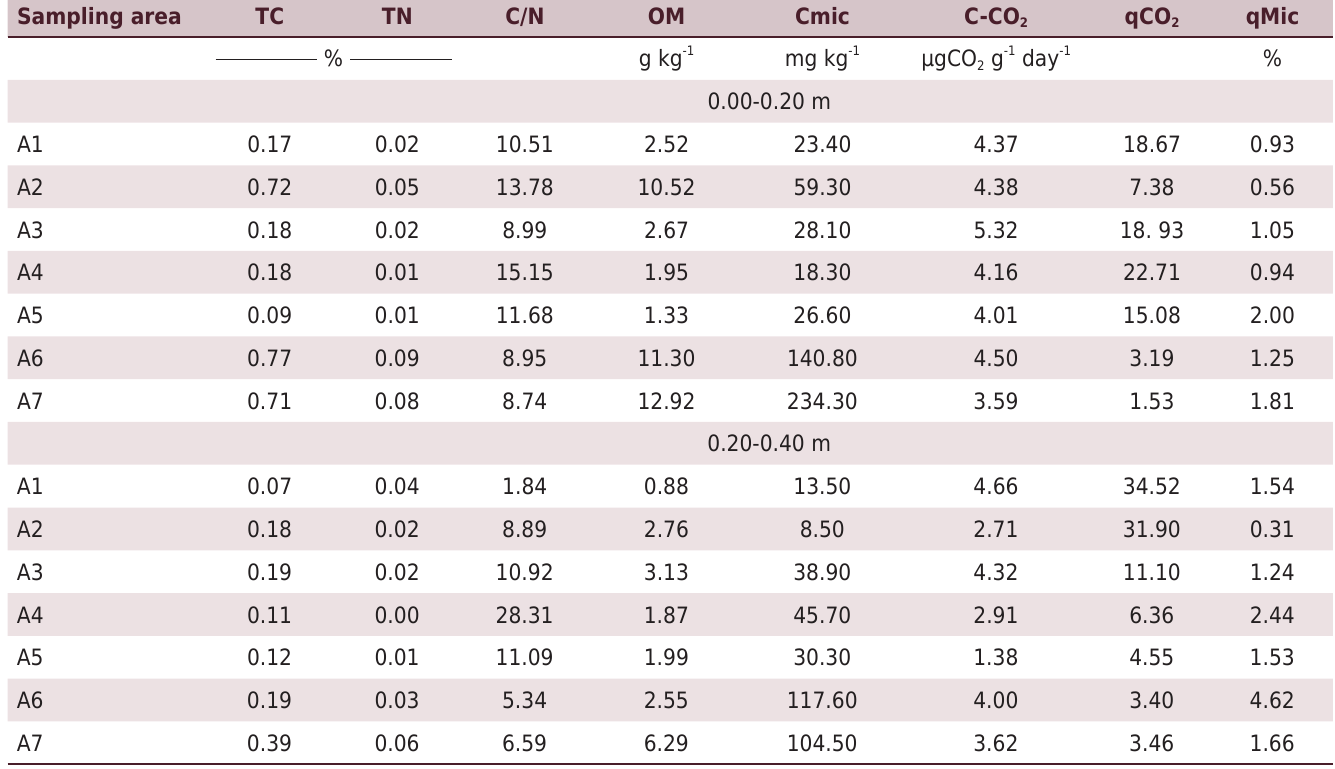
Table 8. Soil biological properties at different sites affected by gold extraction for the 0.00-0.20 and 0.20-0.40 m layers from Serra Pelada Sampling area